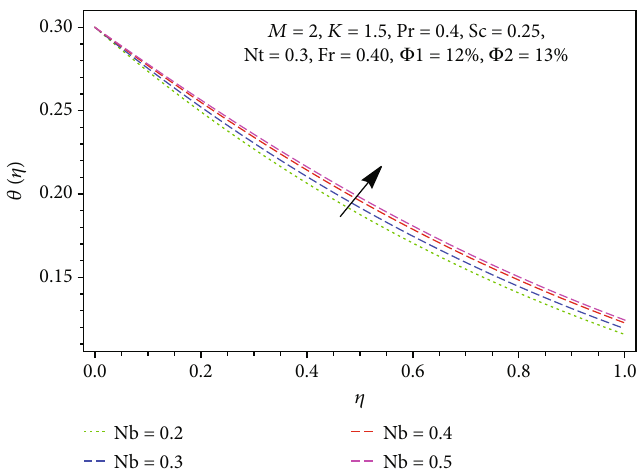
Figure 16: Impact of Brownian motion parameter Nb over energy pro fi le θ ð η Þ .